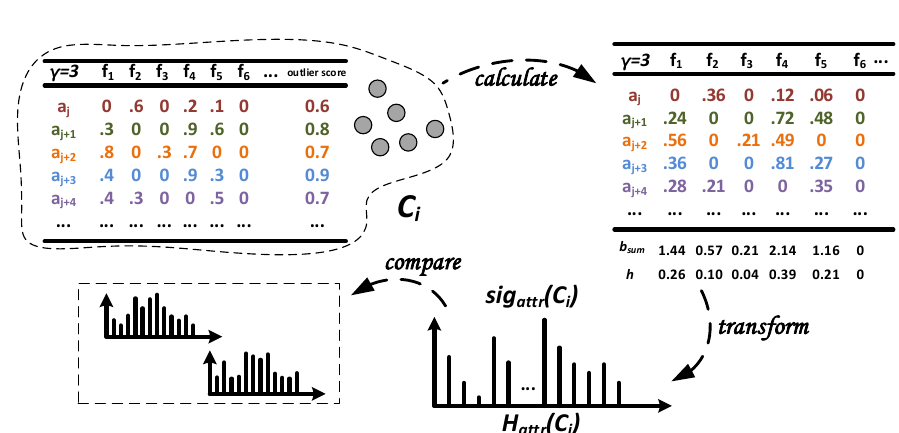
Figure 5. The generation and comparison process of the signature sig attr .